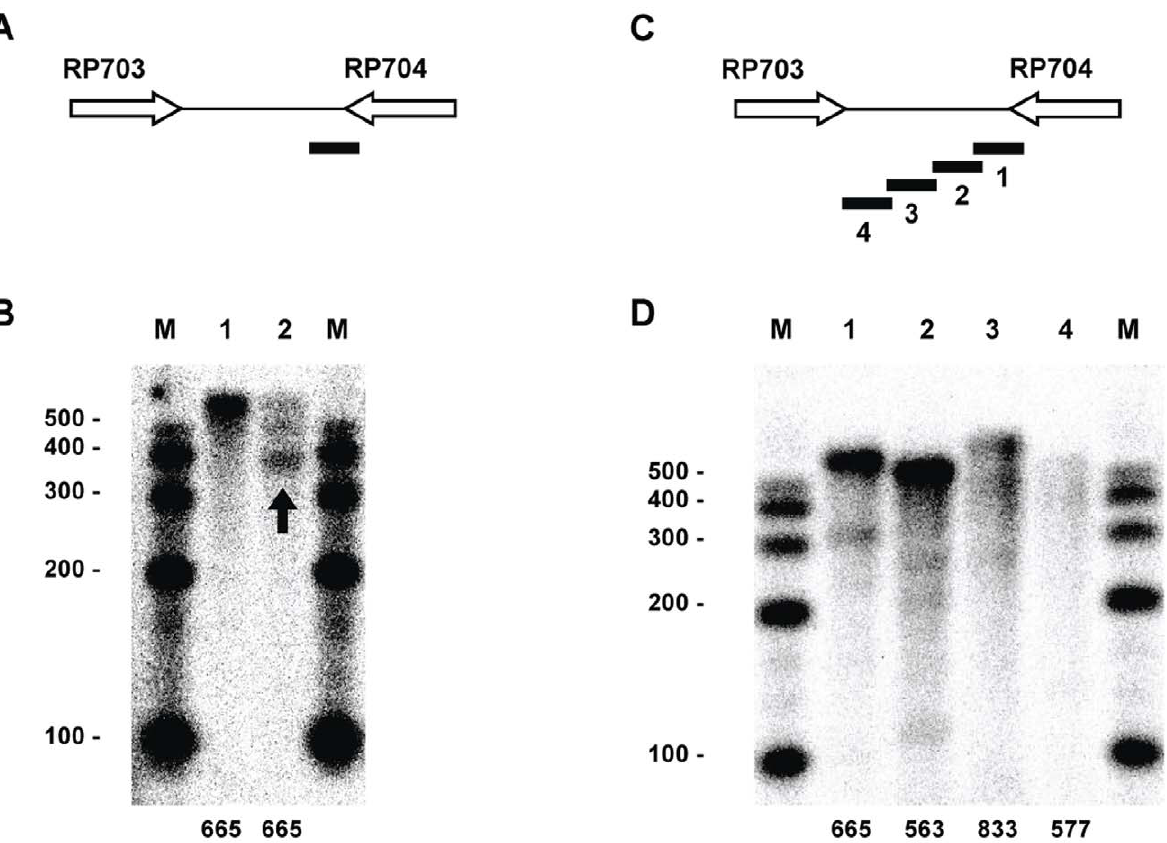
Figure 2. RPA analysis identifying transcripts of the RP703-RP704 intervening region. (A) Schematic indicating the relative position of the RPA probe that spans the predicted intrinsic terminator. This probe is designed to hybridize to RP704 transcripts. (B) RPA analysis with the probe indicated in A using RNA isolated from rickettsiae grown in egg yolk sacs (Lane 1) or L929 cells (Lane 2). (C) Schematic indicating the relative positions of overlapping probes spanning the intergenic region (Table 2). These probes are designed to hybridize to RP704 transcripts. (D) RPA analysis with the probes indicated in Panel B and RNA isolated from egg yolk sac grown rickettsiae. Lane numbers correspond to probe numbers in the schematic. Numbers at the bottom of lanes in B and D correspond to the size of the probe in bases. M, sized markers with sizes (in bases) indicated.